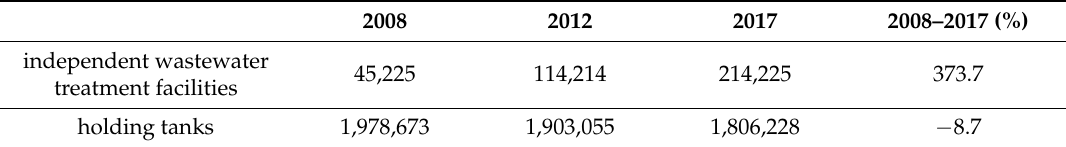
Table 1. Number of holding tanks and household sewage treatment facilities in rural